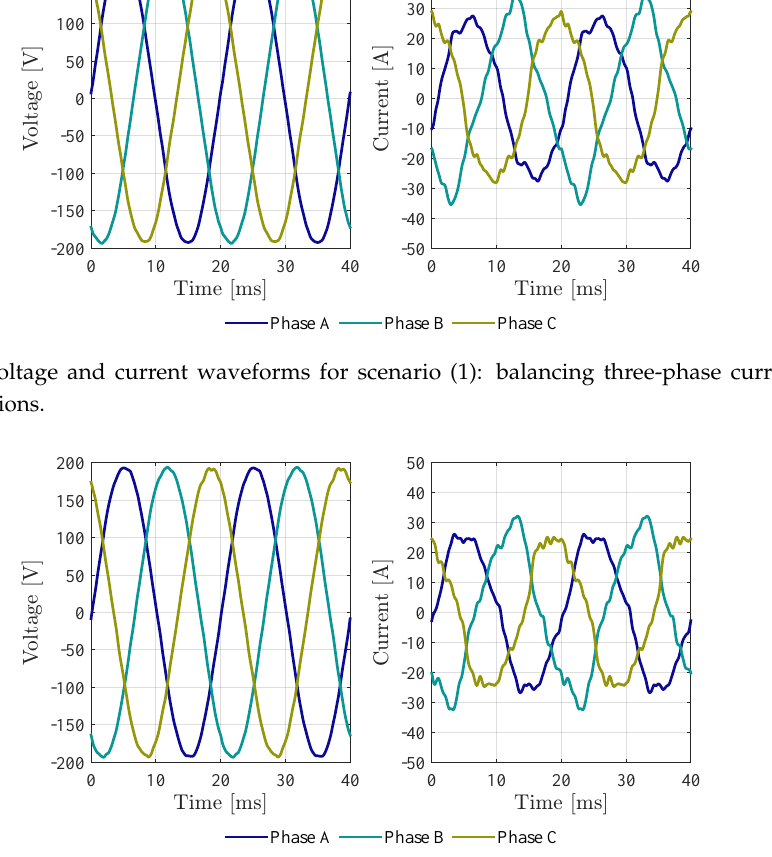
Figure 16. Voltage and current waveforms for scenario (2): balancing three-phase current and compensating the reactive power from the